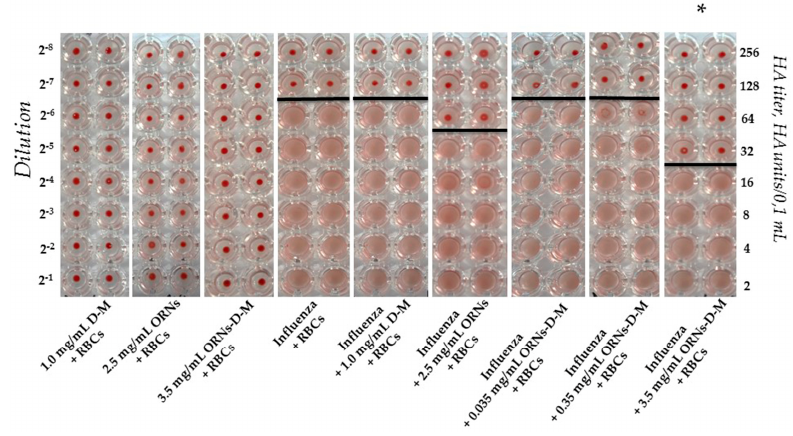
Figure 1. The ORNs- D -M inhibition of the human RBCs 0 (I) agglutination mediated by the influenza A virus H1N1 (A/FM/1/47) HA proteins. D-M + RBCs: negative control of the D-M (1.0 mg/mL); ORNs + RBCs: negative control of the ORNs (2.5 mg/mL); ORNs- D -M + RBCs: negative control of the ORNs- D -M (3.5 mg/mL); Influenza + RBCs: influenza positive control; Influenza + D-M + RBCs: test of the